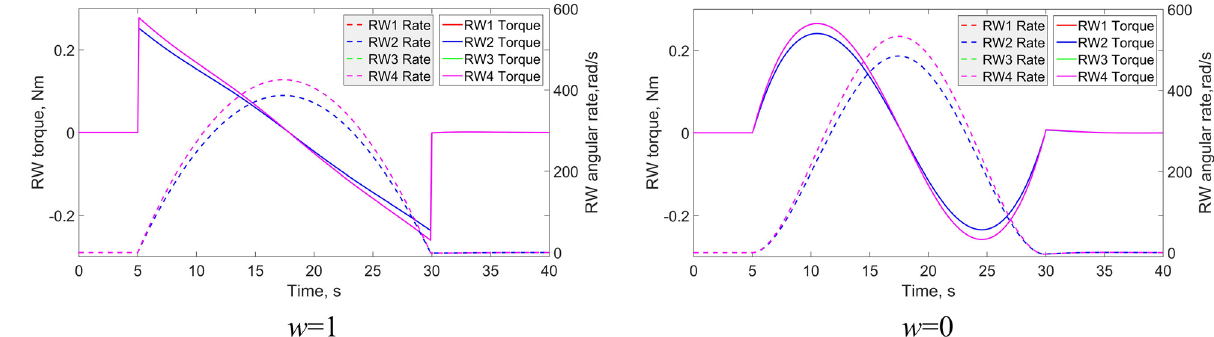
Figure 17: RW control torques and angular velocities for case 1.